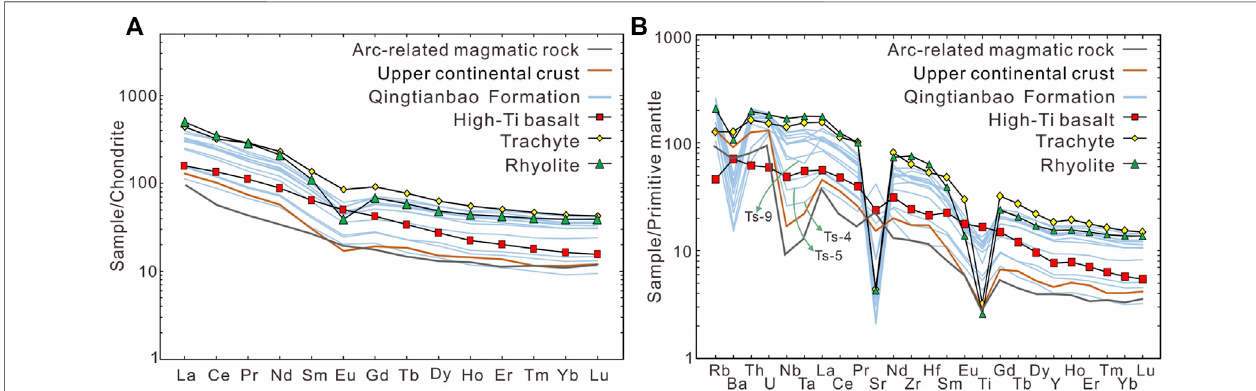
FIGURE 5 | (A) Chondrite-normalized REE diagram. (B) Primitive mantle-normalized trace element diagram. Normalized data are from Sun et al. (1989). The averageuppercontinentalcrust(UCC)(RudnickandGao,2003),arc-relatedmagmaticrocks(Omranietal.,2008),Emeishanhigh-Tibasalts(Xiaoetal.,2003,2004;Fan et al.,2008;Song etal.,2008; Anhet al.,2011;Laiet al.,2012;Huang etal.,2014),Emeishanrhyolites(Xuetal.,2010;Chenget al.,2017;Hei etal.,2018; Huanget al., 2022a), and Emeishan trachytes (Shellnutt and Jahn, 2010; Xu et al., 2010) are displayed for comparison.